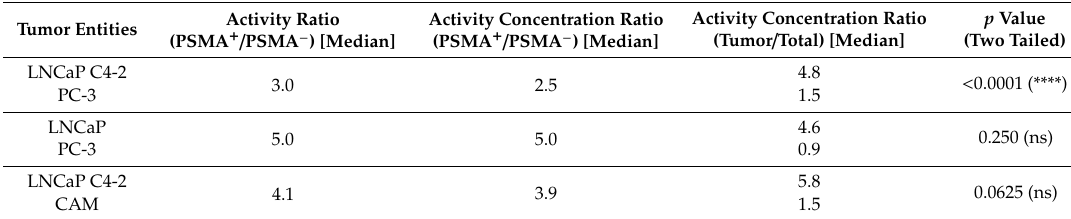
Table 1. Medians of the di ff erent calculated ratios and the respective p -values. p -values < 0.05 are assumed statistically significant. Low sample numbers were not su ffi cient for statistical evaluation (ns = not significant), but the results still provide information about the tendency in the experimental